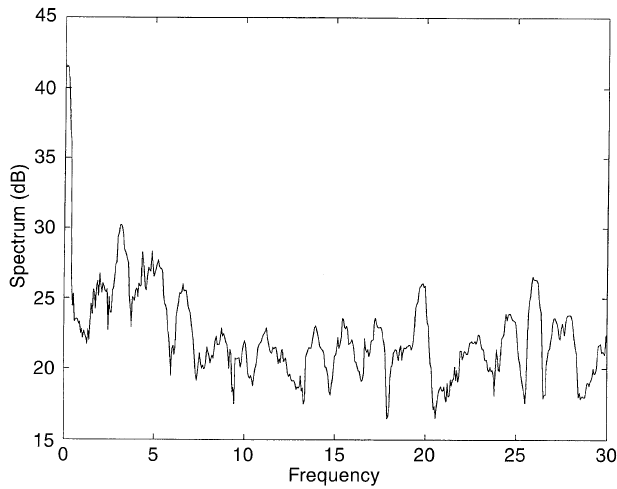
Fig. 10. Spectrum of the ion velocity; frequencies are in h